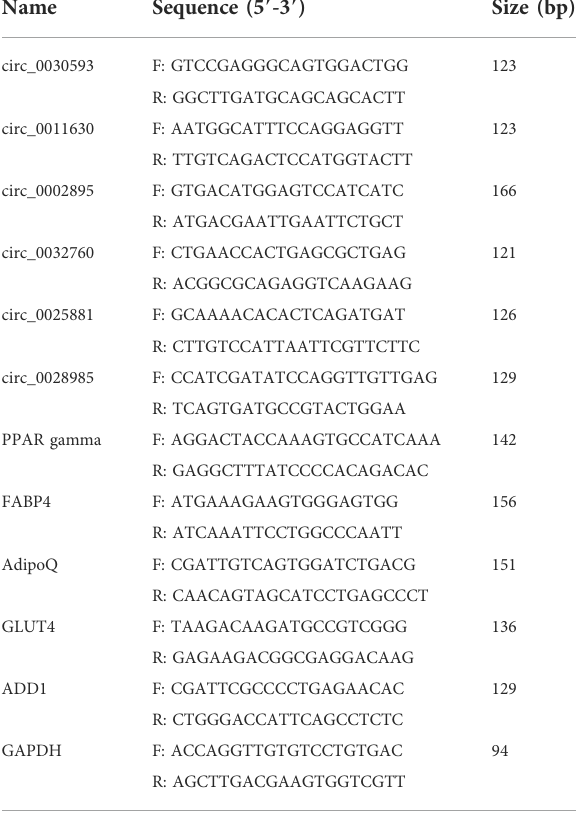
TABLE 1 Primers used for RT ‒